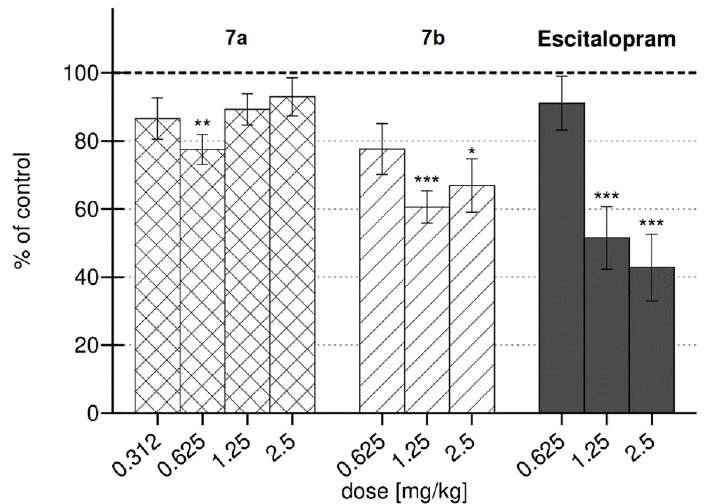
Figure 4. Effects of compounds 7a·HCl , 7b·HCl and escitalopram in FST in mice. The data represent the mean ± SEM, n = 7–9 mice per group; one-way ANOVA followed by Bonferroni’s post hoc test.